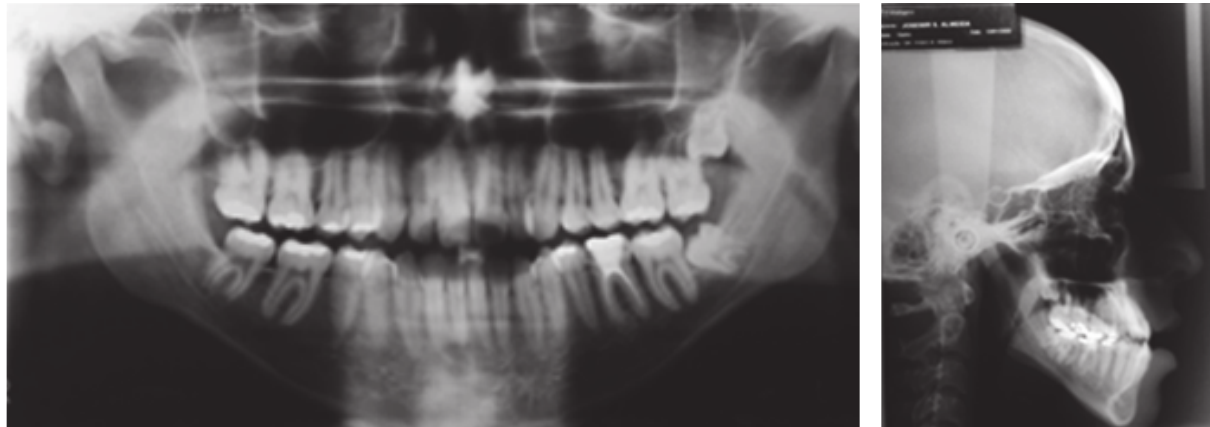
Figure 2: Pretreatment panoramic and cephalometric